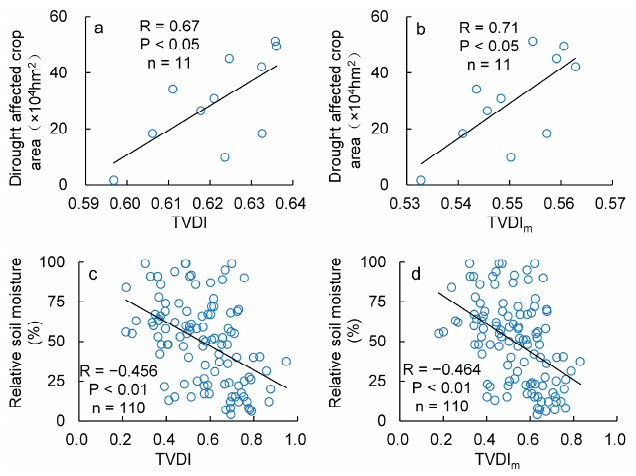
Figure 13. The scatterplots and correlation coefficient R values between TVDI ( a ); TVDI m ( b ); and drought affected crop area and TVDI ( c ); TVDI m ( d ), and relative soil moisture.